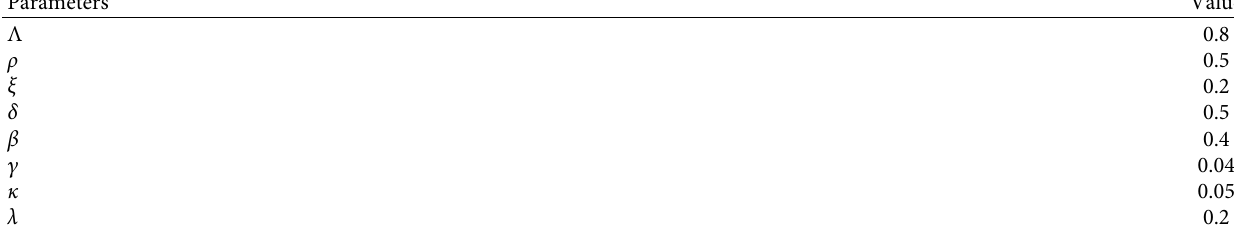
Table 2: Numerical values for the parameters given in model (2).